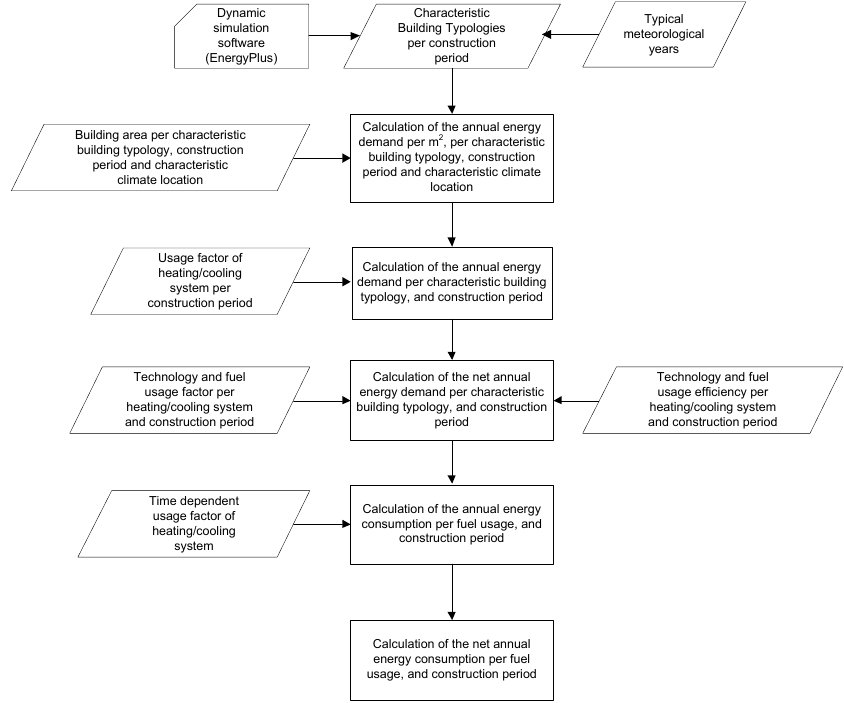
Figure 1. Schematic presentation of the 2EMRS calculation algorithm.